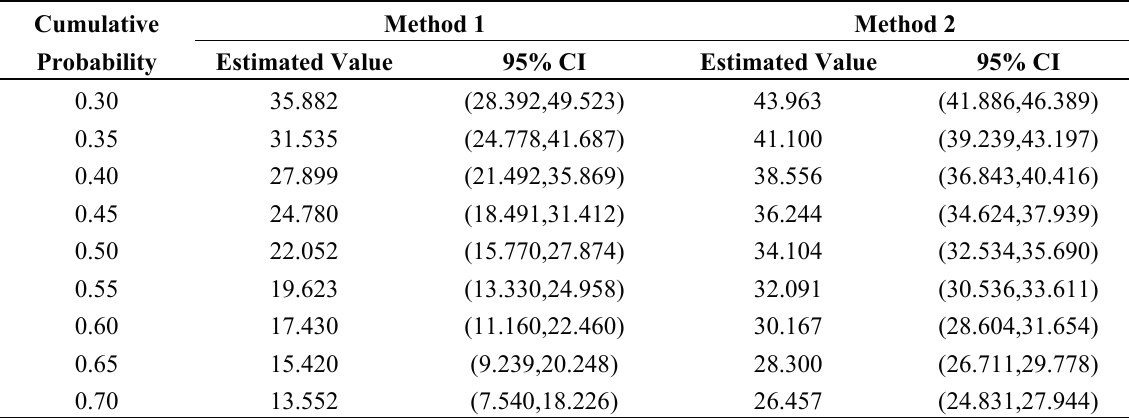
Table 3. Payment level measurement among empty nesters.